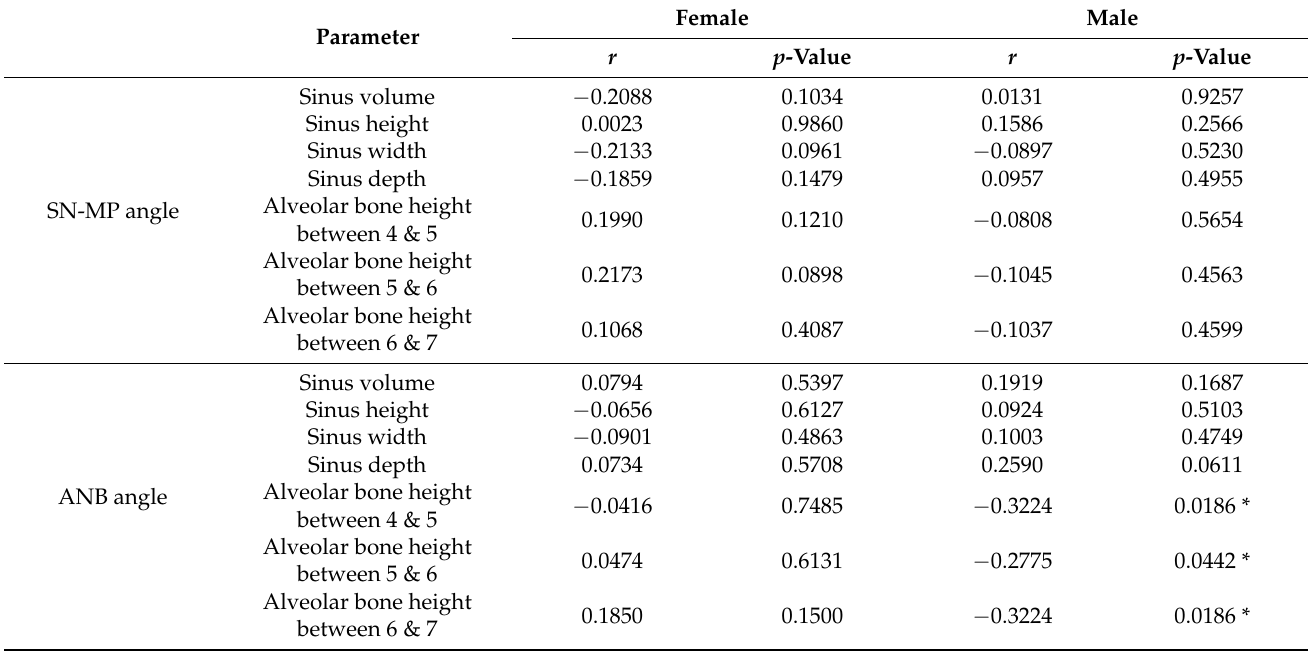
Table 3. Pearson’s correlation coefficient ( r ) calculation and statistical analysis results between maxillary sinus measurements and SN-MP angle or ANB angle for all included skeletal class I subjects. 4: first premolar, 5: second premolar, 6: first molar, 7: second molar. *: p < 0.05.